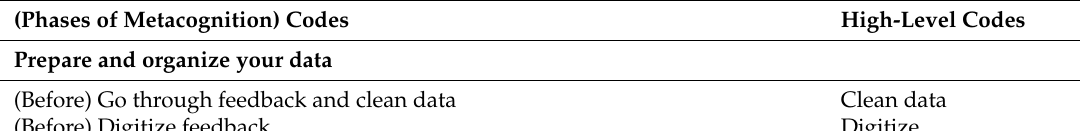
Table A1. Themes identified along with the associated codes and respective high-level